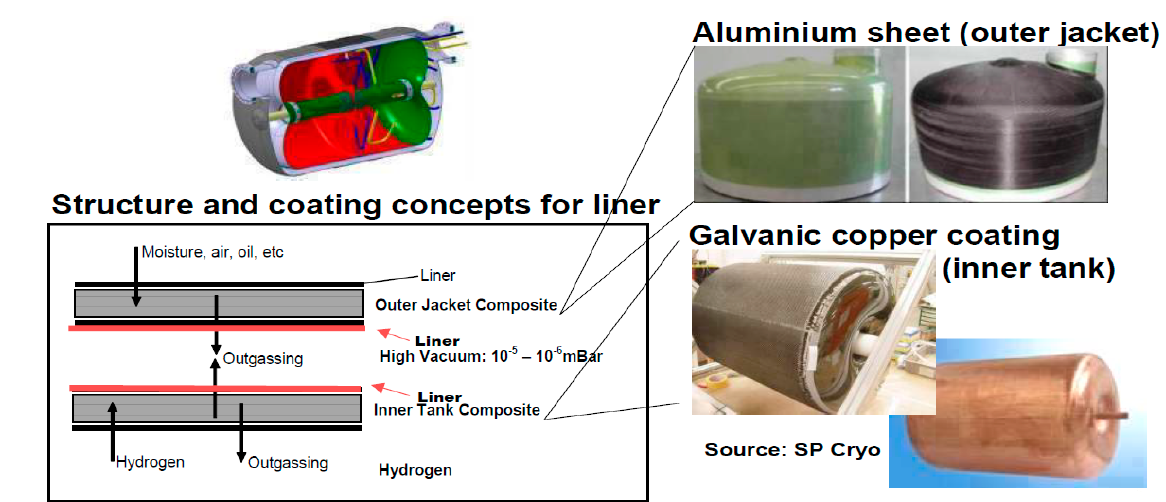
Figure 25. Development of test procedures for C-H 2 vessels [106].